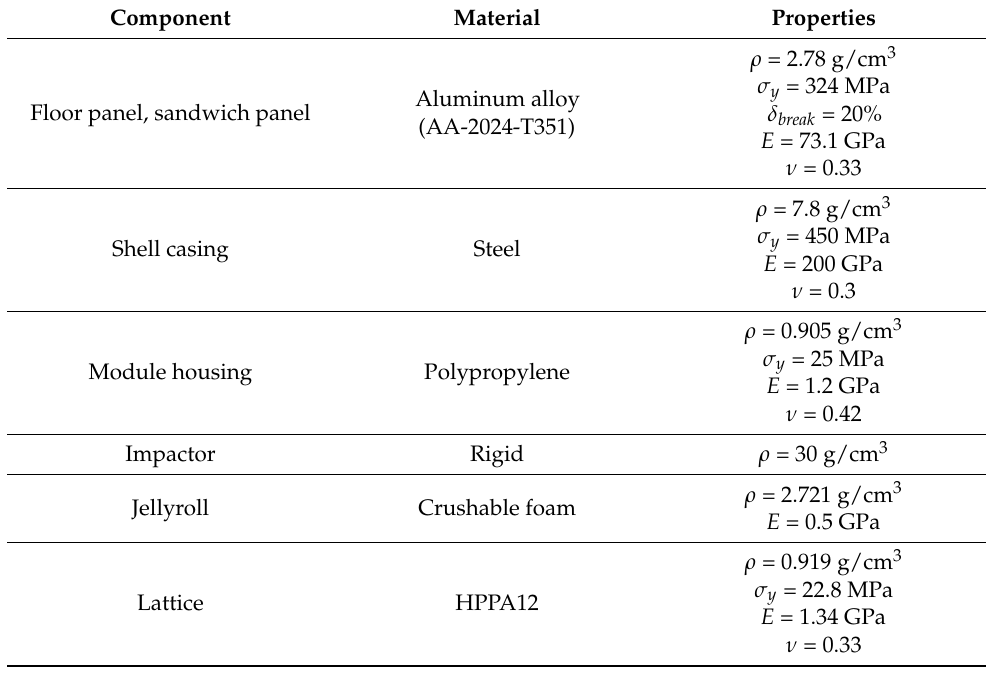
Table 2. Material